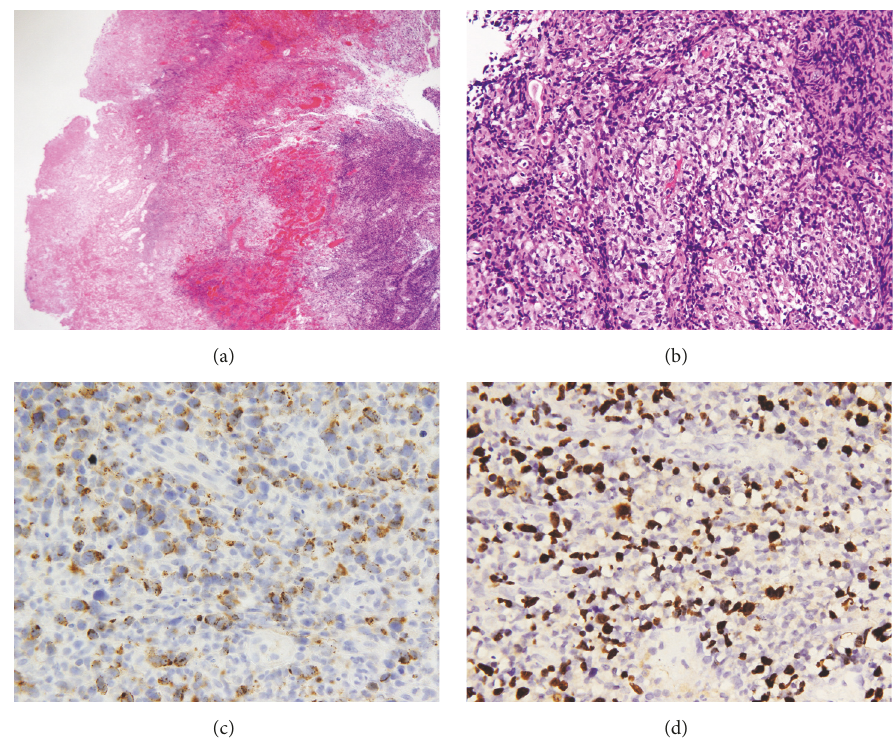
Figure 5: Morphological features of nasal tumor. (a) Low-power view shows diffuse cellular infiltrates with necrosis and mucosal ulcer (H&E, 100x). (b) High-power view shows a mixture of small-, medium-, and large-sized cells with angiocentric growth pattern (H&E, 200x). Immunohistochemical study: (c) the tumor cells are positive for granzyme B (C). Nuclei are positive for EBER by in situ hybridization (d)